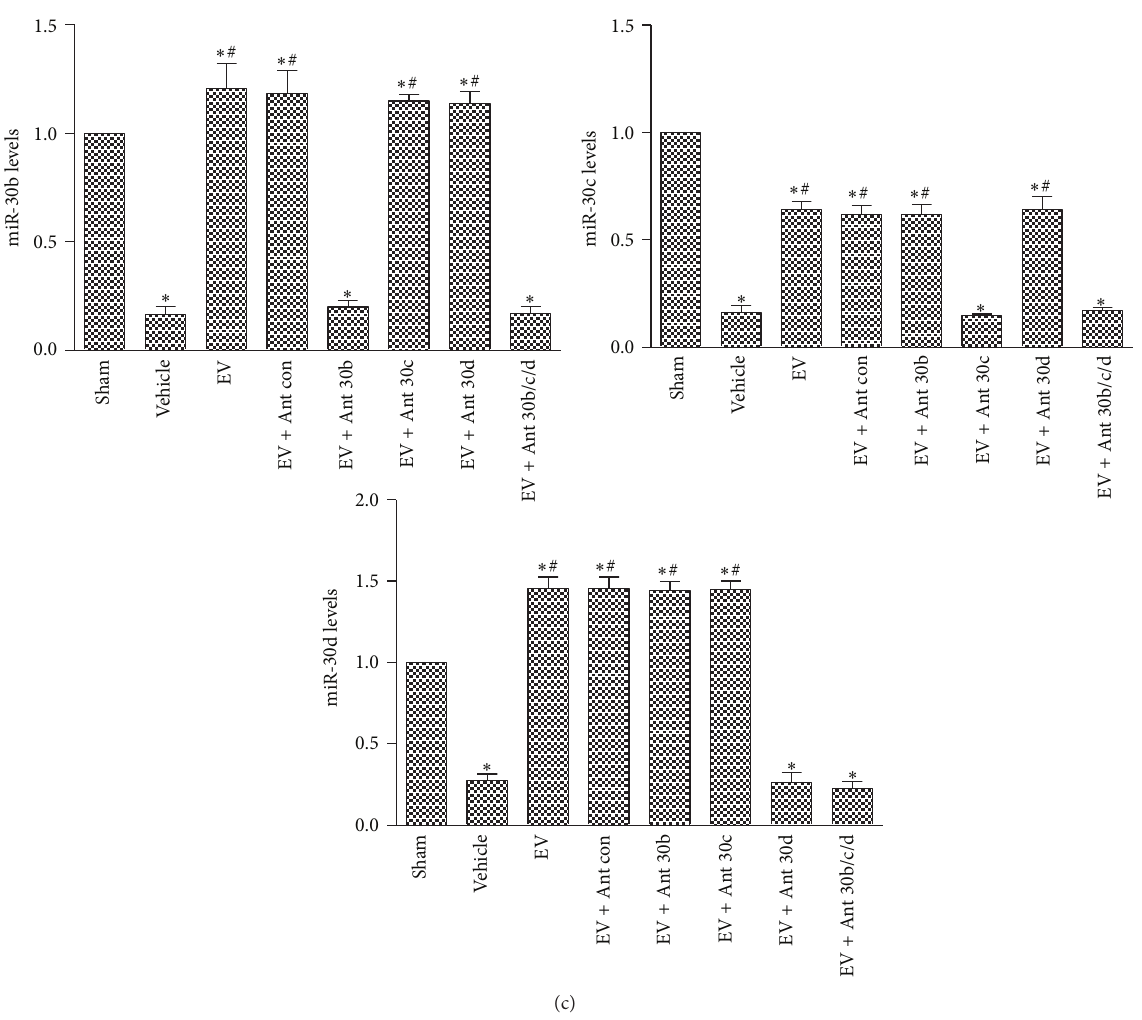
Figure 2: hWJMSC-EVs deliver and restore the expression of miR-30 in injured renal tubular epithelial cells. (a) Representative quantitative reverse transcriptase- (qRT-) PCR analysis for miR-30b/c/d in kidney tissues 24 hours after sham, IRI, or EVs treatment. (b) qRT-PCR analysis of miR-30b/c/d content in EVs derived from MSCs cultured with vehicle alone (wild-type) or subjected to miR-30b/c/d antagomir. (c) miR- 30b/c/d levels in kidney in different experimental conditions, including sham, vehicle, EVs, and miR-30b/c/d antagomir-treated EVs group. Data in (a) and (c) are presented as mean ± SD; 𝑛 = 6 ; ∗ 𝑃 < 0.05 , versus sham; # 𝑃 < 0.05 , versus vehicle.